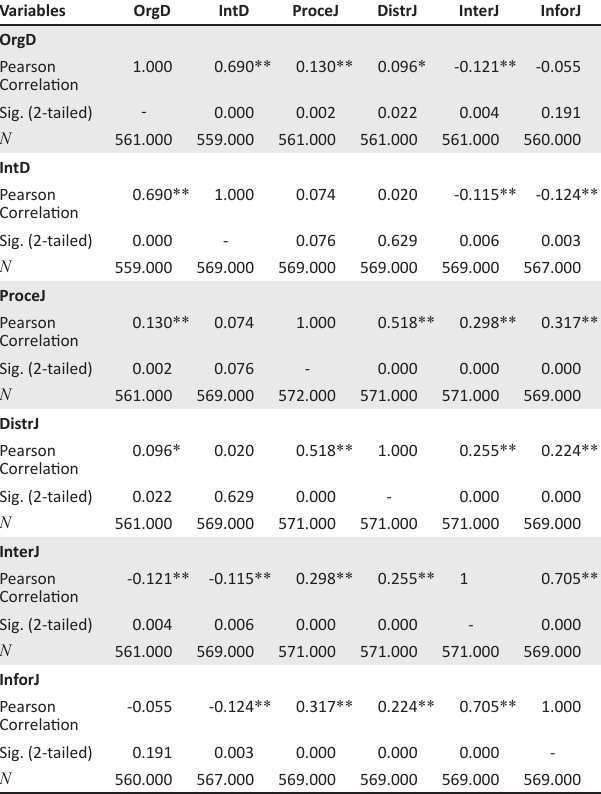
TABLE 2: Pearson correlation: organisational justice versus workplace deviance.